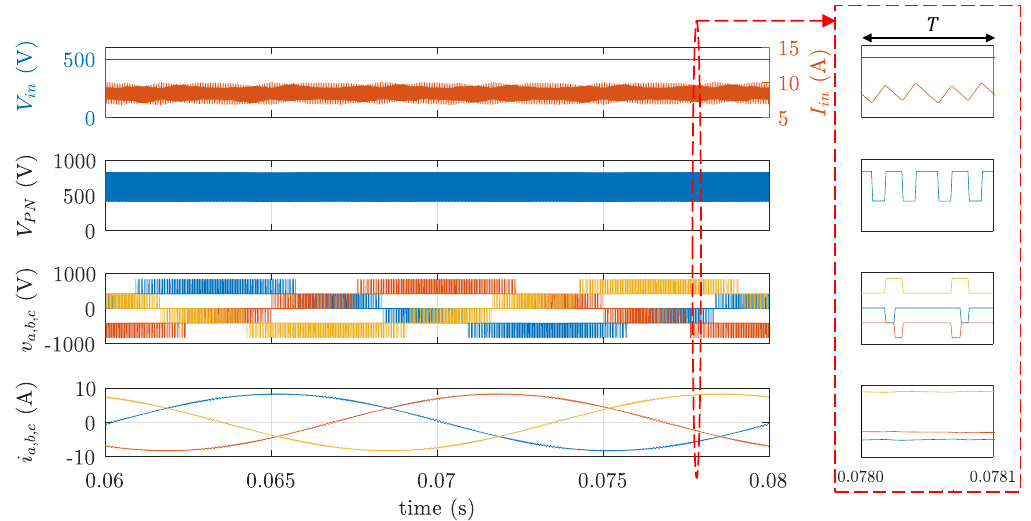
Figure 7. Simulation results for the UST/LST strategy, switching frequency 10 kHz, m = 0.8, and 𝐷 0 = 0.2 . Left, top to bottom: input voltage ( 𝑉 𝑖𝑛 ) and input current ( 𝐼 𝑖𝑛 ); DC-link voltage ( 𝑉 𝑃𝑁 ); and line-to- line voltages before filtering ( 𝑣 𝑎𝑏 , 𝑣 𝑏𝑐 , and 𝑣 𝑐𝑎 ) and output currents ( 𝑖 𝑎 , 𝑖 𝑏 , and 𝑖 𝑐 ). Right: zoomed views for one switching cycle.